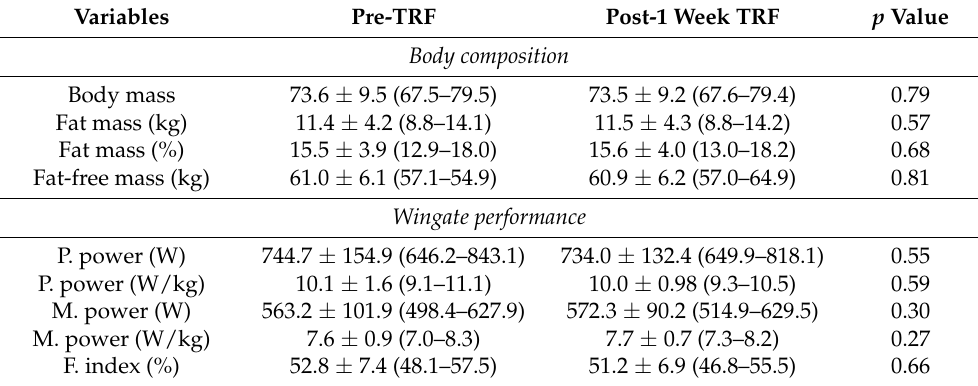
Table 2. Body composition and Wingate-derived variables obtained before and after one week of time-restricted feeding